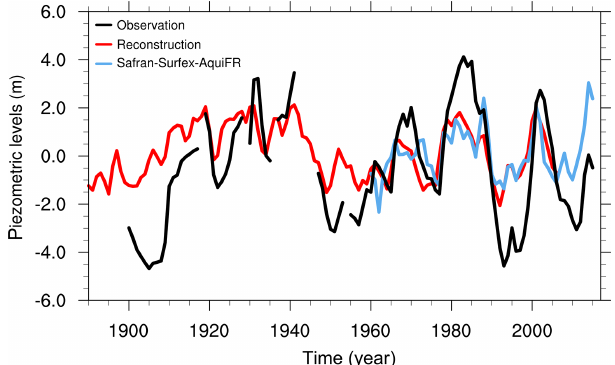
Figure 5. Annual maximum of daily river flows for the Seine at Paris. Black: observations. Red: Seine reconstruction. Blue: refer- ence simulation (SAFRAN–SURFEX–Aqui-FR).